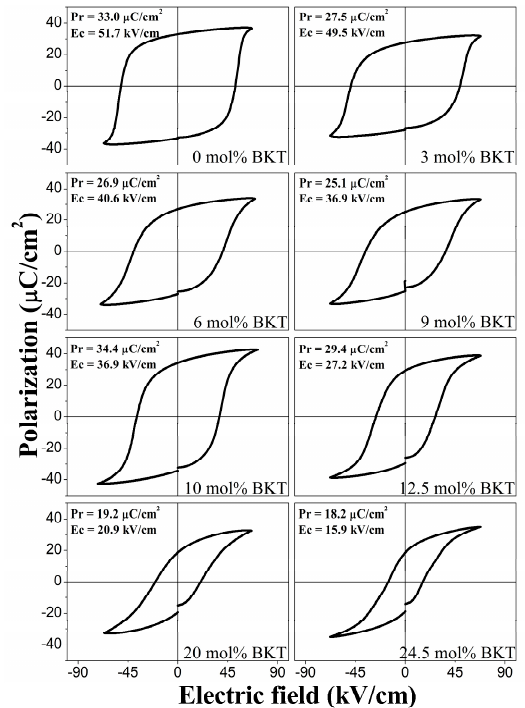
Figure 7. Polarization ( P )—electric field ( E ) hysteresis loops measured at 1 Hz and room temperature as a function of composition.